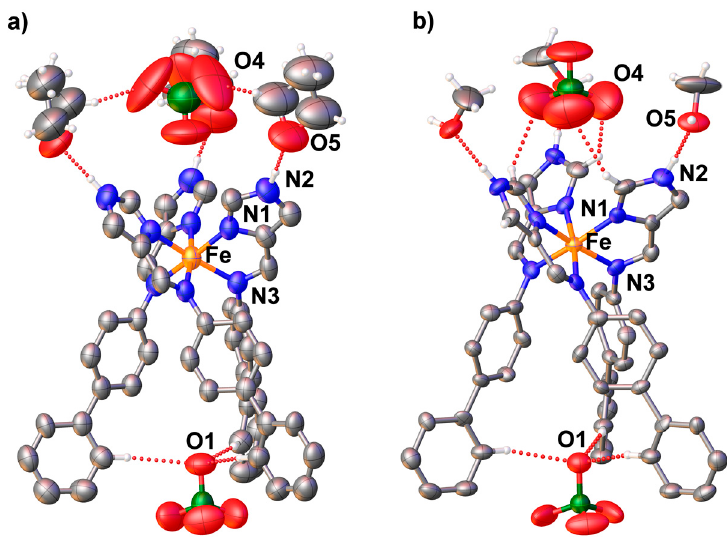
Figure 2. View of the molecular unit of ( a ) 1 and ( b ) 2 . Only selected hydrogen atoms and labels are shown in the interests of clarity. Ellipsoids are drawn at 50% probability.